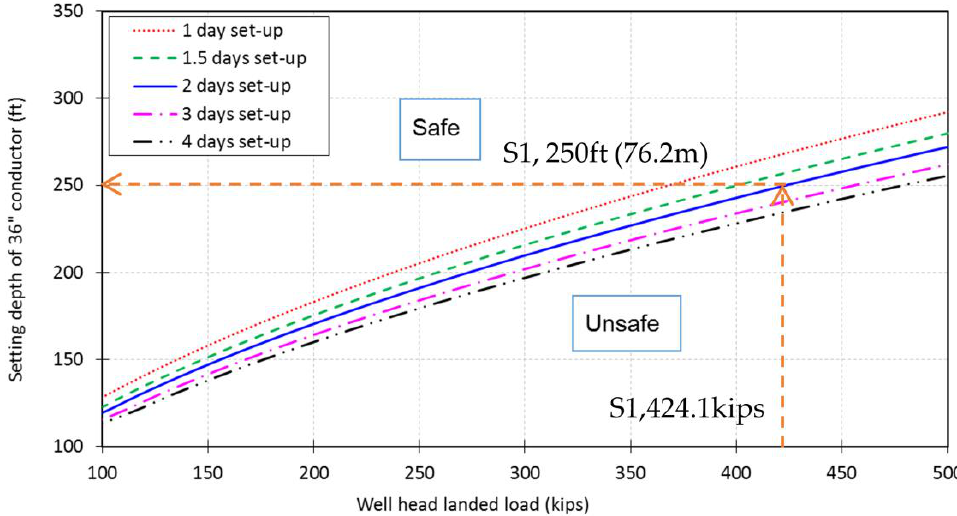
Figure 8. Landed weight vs. setting depth of 36” surface conductor.